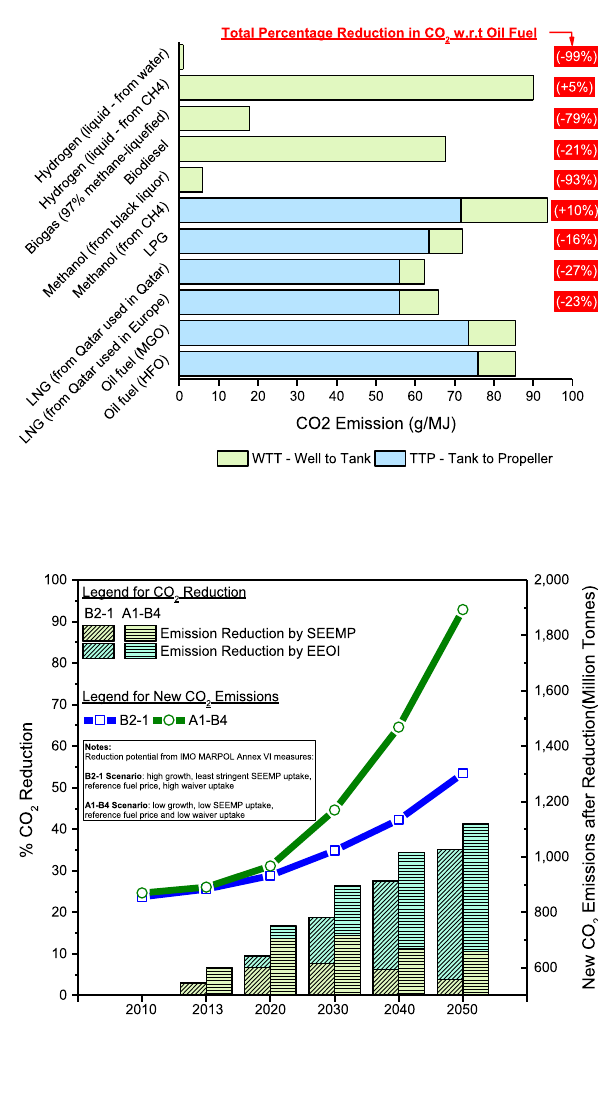
Fig. 26 CO emission of alter- 2 native fuels during produc- tion and on-board ship, data derived from DNV-GL [169]